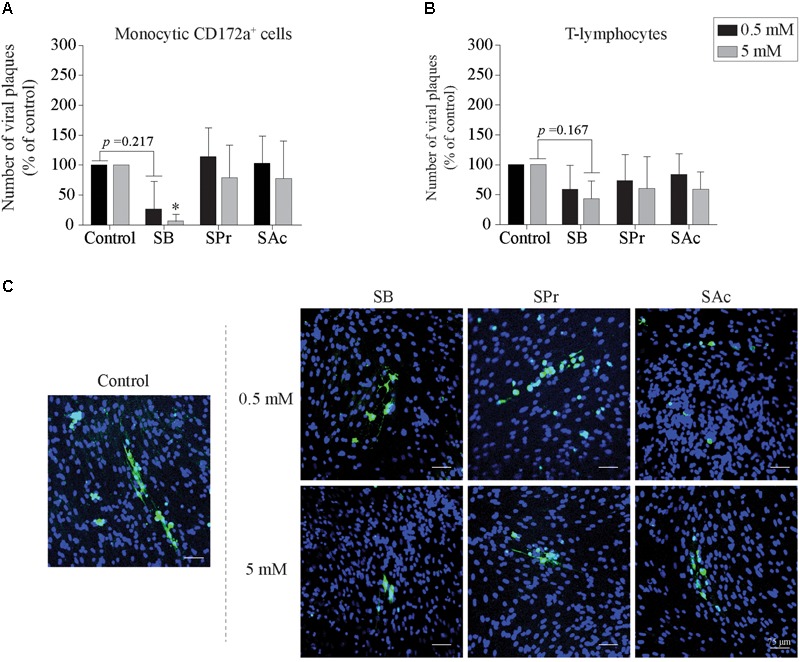
Viral transfer from mononuclear cells to SCFA-pretreated endothelial cells (EC). The number of viral plaques in SCFA-treated EC were analyzed after 36 h of co-cultivation with EHV1-inoculated (A) monocytic CD172a+ cells, or (B) T-lymphocytes. Number of plaques were counted per 0.25 cm2. Three independent experiments were performed and data are represented as means + SD. Statistical significant differences are shown with asterisks: ∗
p < 0.05. (C) Representative confocal images of EHV1 viral plaques in EC. Viral proteins were shown in green (FITC), nuclei were counterstained in blue (Hoechst).